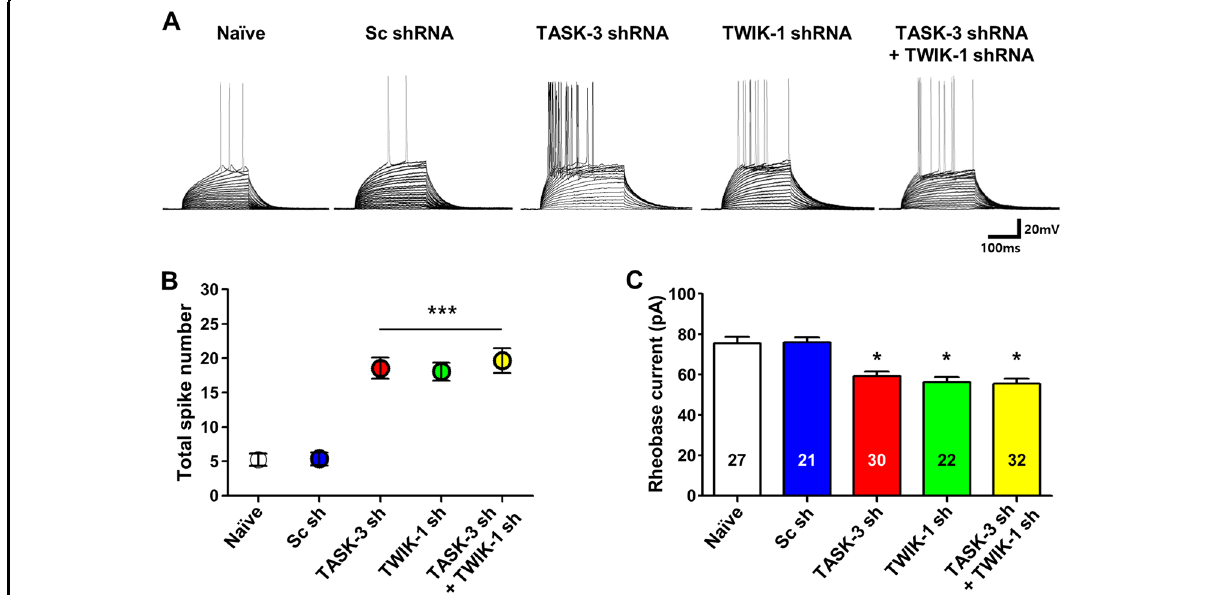
Fig. 4 TWIK-1/TASK-3 heterodimeric channels contribute to the intrinsic excitability of DGGCs. a Representative traces of the membrane potential to stepwise current injections recorded from naive DGGCs ( n = 27, N = 3) or DGGCs infected with Ad-Sc shRNA ( n = 21, N = 3), Ad-TWIK-1 shRNA ( n = 30, N = 3), Ad-TASK-3 shRNA ( n = 22, N = 3), or both Ad-TWIK-1 shRNA and Ad-TASK-3 shRNA ( n = 32, N = 3). The resting membrane potentials of the cells was maintained at − 70 mV by constant current injections, and the depolarizing current was then injected stepwise in 5-pA increments. b The number of spikes indicated that the neuron infected with Ad-TWIK-1 shRNA and Ad-TASK-3 shRNA were more excitable compared to control mice. The recordings were performed in arti fi cial cerebrospinal fl uid containing 50 µM D-AP5, 10 µM CNQX, 10 µM bicuculline, 10 µM CGP 55845, 2 mM TEA, and 0.5 mM NiCl 2 , with a pipette solution containing 5 mM QX314. c Averaged values of rheobase currents in naive cells ( n = 27 cells, N = 3 mice) and cells expressing Ad-Sc shRNA ( n = 21 cells, N = 3 mice), Ad-TWIK-1 shRNA ( n = 30 cells, N = 3 mice), Ad-TASK-3 shRNA ( n = 12), or both Ad-TWIK-1 shRNA and Ad-TASK-3 shRNA ( n = 32 cells, N = 3 mice). All values are means ± SEM. * P < 0.05, *** P <